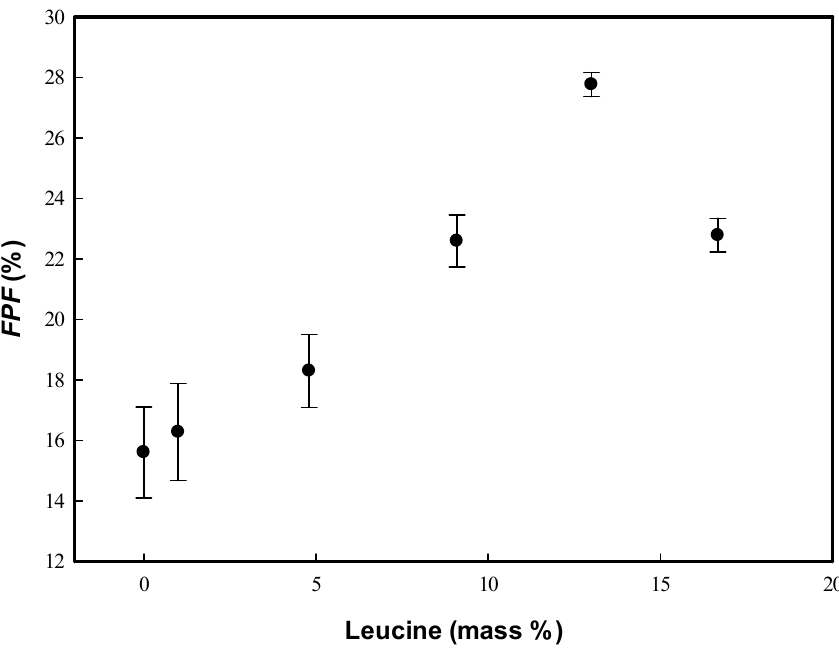
Figure 6. Fine particle fractions ( FPFs ) of the HP- β -CD carrier powder varying with the addition of leucine (mass%).